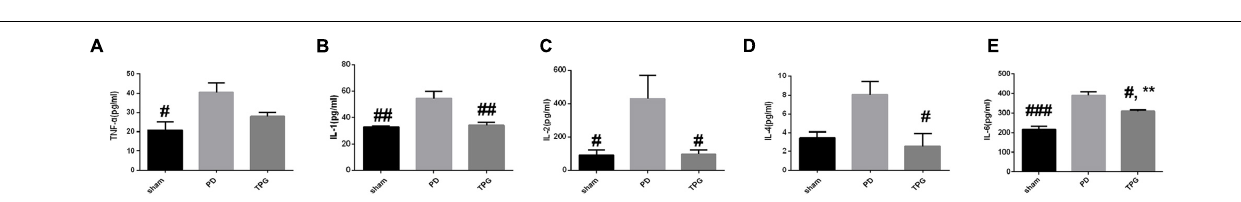
FIGURE 7 | Functional prediction analysis. The data were analyzed by unpaired Student’s t -test (* p < 0.05).